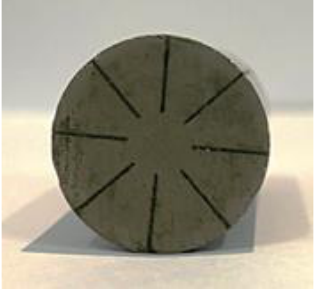
Figure 2. Photo of a radially slotted Terfenol-D rod.